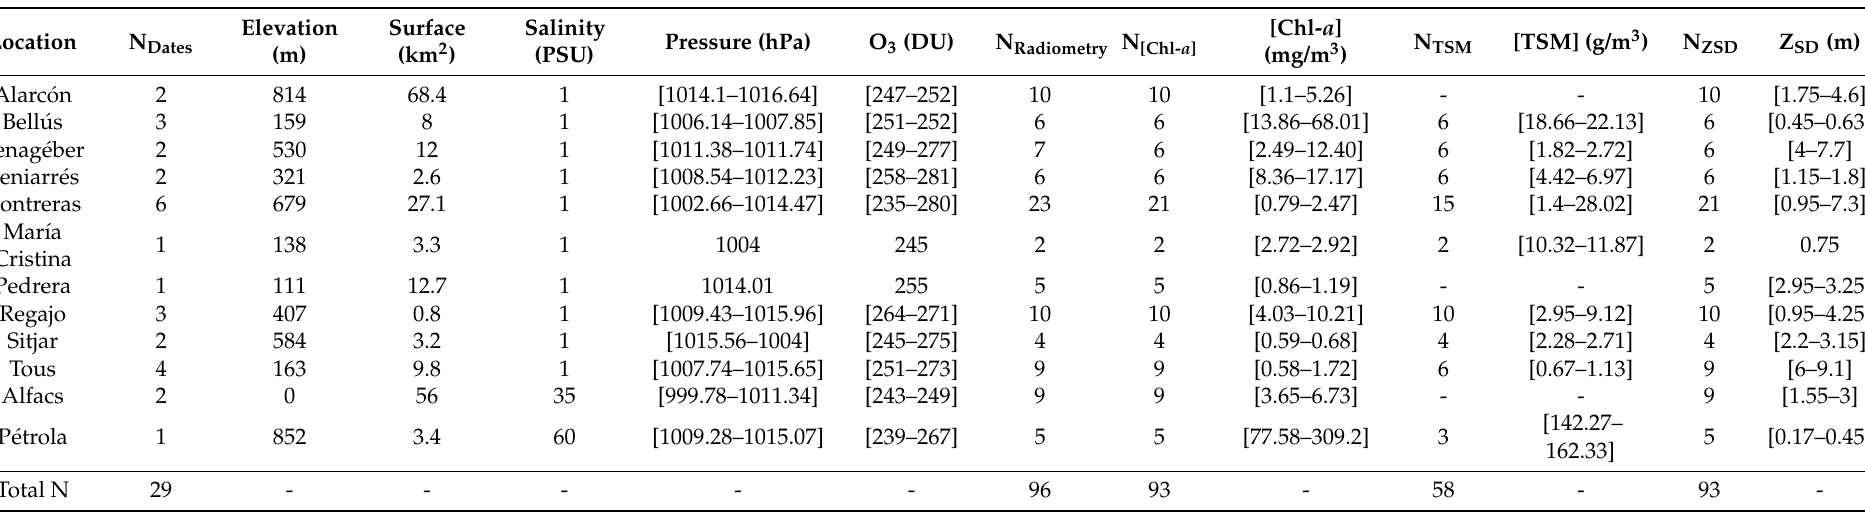
Table 1. Descriptors of study areas by location, including the number of valid S2 images and in situ measurements (N xxx ), the altitude (elevation), surface, salinity, and the ranges within S2 dates of atmospheric pressure, ozone (O 3 ), [Chl- a ], [TSM], and Z SD